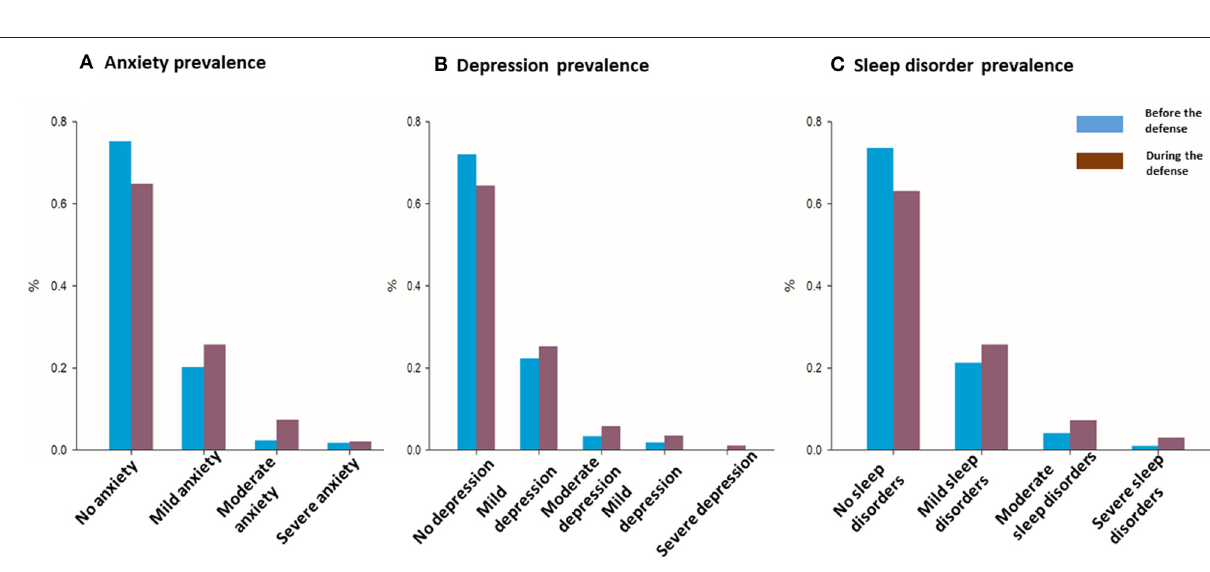
FIGURE 3 | Anxiety, depression, and sleep disorders incidence before and during COVID-19